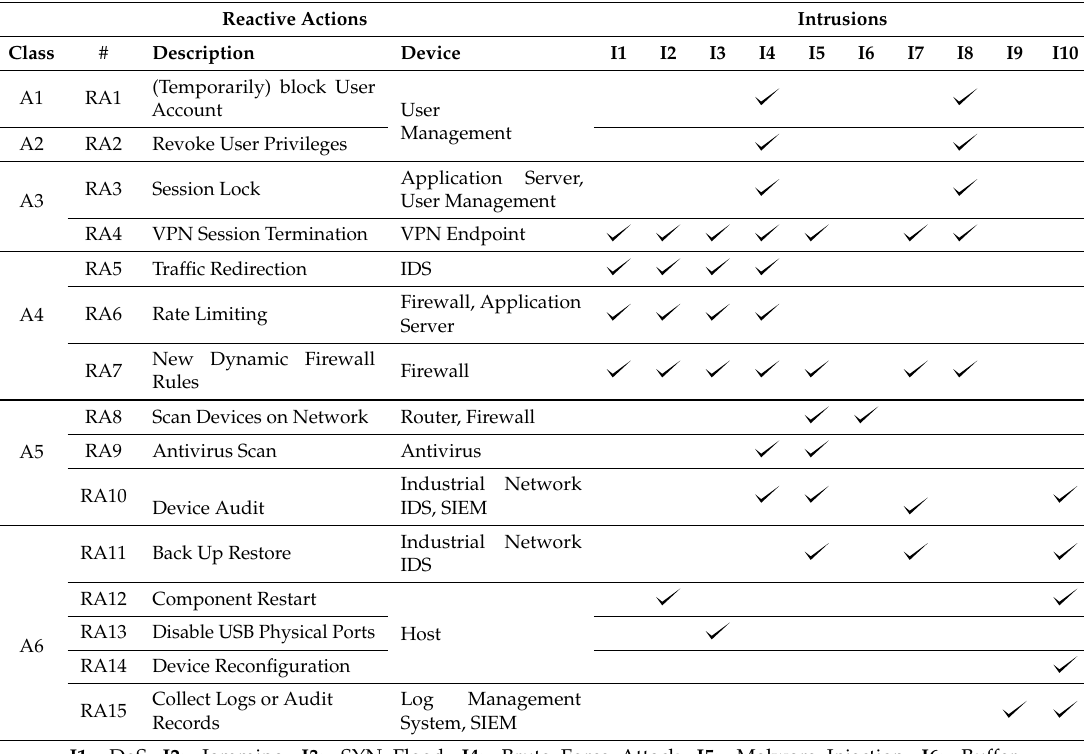
Table 5. Mapping between examples of intrusions and their corresponding reactive